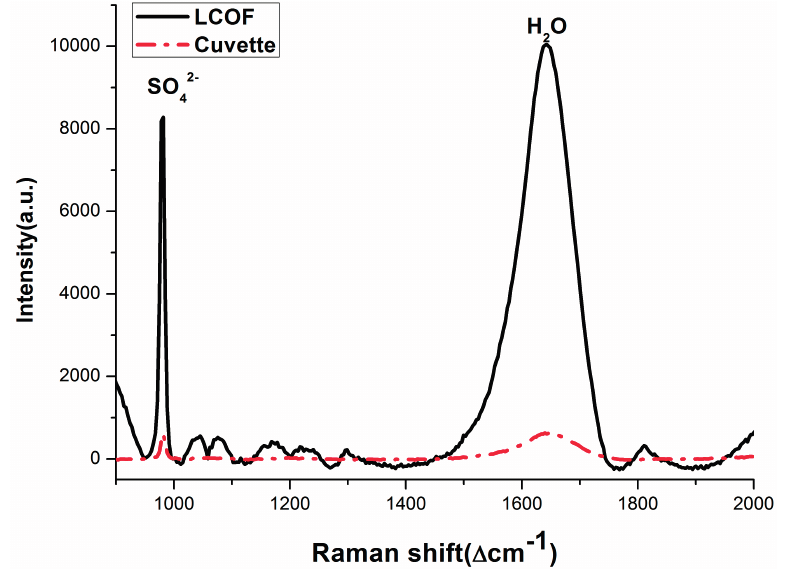
Figure 8. Raman spectra of 30 mmol/L sulfate solution using the LCOF-Raman experimental (LWCC-3050) setup and conventional experimental setup